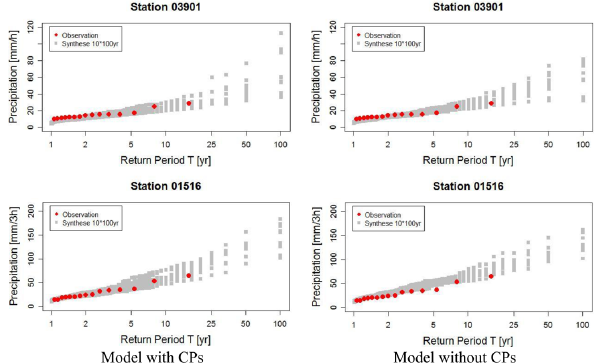
Fig. 5. Extreme values, 10 synthetic time series (100yr) vs. obser- vation